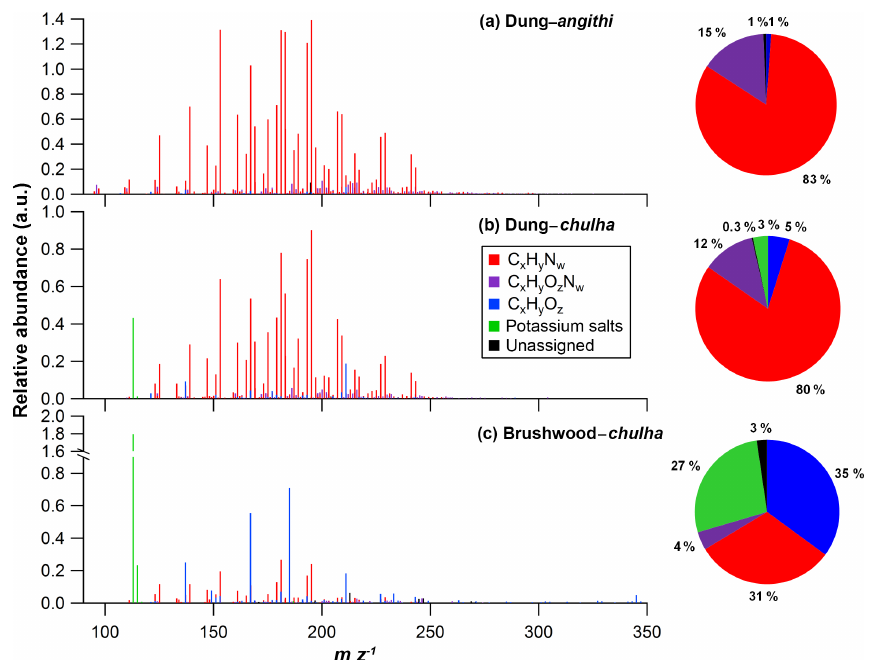
Figure 2. Representative nano-DESI mass spectra collected for (a) dung– angithi (b) dung– chulha and (c) brushwood– chulha cook fires. Relative abundance is plotted against m/z . Peaks are colored by their elemental makeup, C x H y N w (red), C x H y O z N w (purple), C x H y O z (blue), potassium salts (green), and unassigned (black). The pie charts illustrate the fraction of count-based, normalized peak abundance that is attributed to each elemental